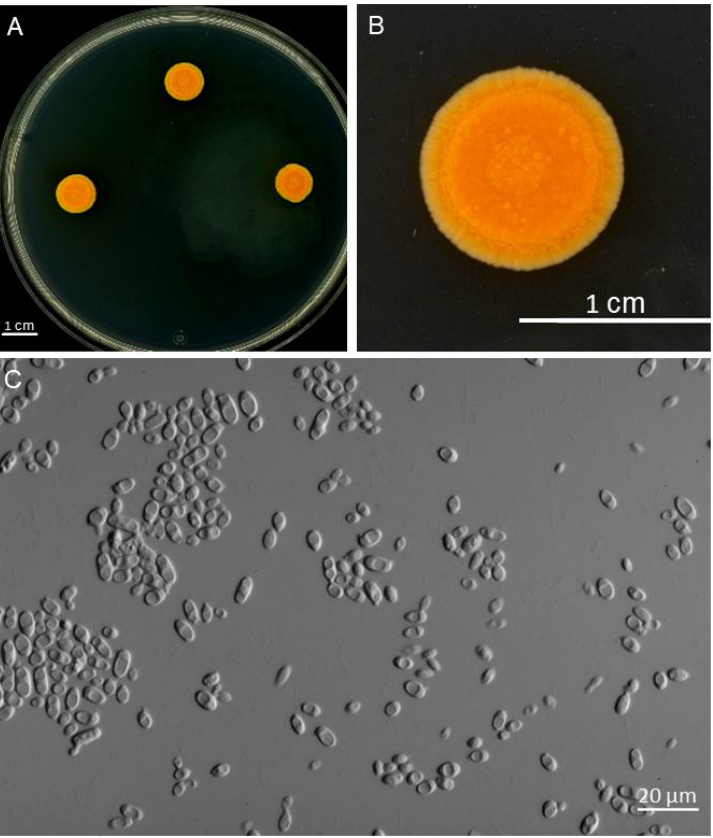
Figure 4. Colonies ( A , B ) and cells ( C ) of Microsporomyces cladoniophilus sp. nov on MYA after 10 days. Host range and distribution: Currently only reported from Cladonia rei lichen from Chiba Prefecture,